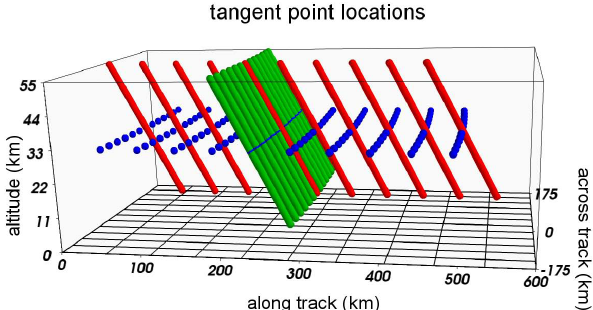
Fig. 2. Illustration of the PREMIER IRLS dynamics mode mea- surement grid. Symbols indicate the locations of tangent points of individual measurements. The green coloured spheres represent the measurements of a single image of PREMIER. Each blue orb rep- resents a full profile and thereby the horizontal component of the measurement grid of ten consecutive images. In our simulations, we generally use only measurements of the central track, of which ten consecutive vertical measurement profiles are shown coloured in red. As the tangent points of a single profile are spaced at vertical intervals of 500m, the orbs representing it are merged into a vertical line. For the outermost measurement tracks, the tangent-points lie generally not within the idealized 2-D measurement track, but are displaced from it by up to 2.2km in the across-track